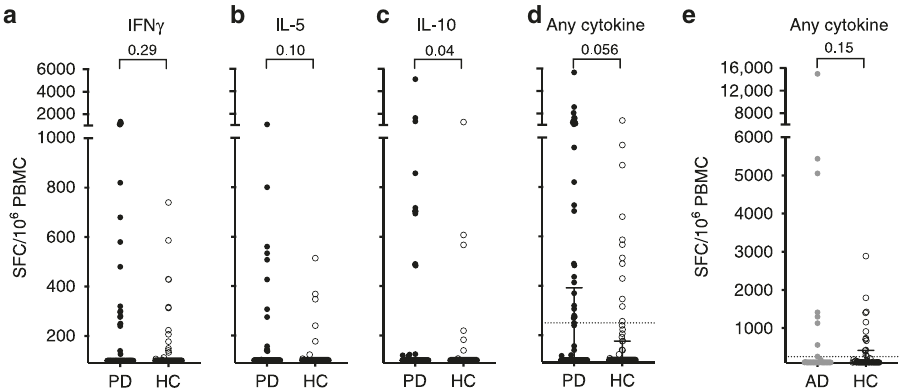
Fig. 2 Reactivity to α -syn in patients with PD or AD as compared with HC. Magnitude of responses a IFN γ , b IL-5, c IL-10, and d sum of IFN γ , IL-5, and IL-10 against the α -syn peptide pool as SFC per 10 6 cultured PBMC. Each point represents one participant. Closed circles, patients with PD ( n = 77); open circles, controls ( n = 69). One-tailed Mann – Whitney test. As many participants showed no response, numerous points are at the limit of detection (100 SFC). Median± interquartile range is displayed, but note that median values are at the limit of detection. The top interquartile range is visible in d . e Sum of IFN γ , IL-5, and IL-10 against the α -syn peptide pool as SFC per 10 6 cultured PBMC. Each point represents one participant. Gray circles, patients with AD ( n = 38); open circles, controls ( n = 41). Two-tailed Mann – Whitney test. As many participants showed no response, numerous points are at the limit of detection (100 SFC). Median± interquartile range is plotted, but the median values are at the limit of detection. The top interquartile range is visible for HC.